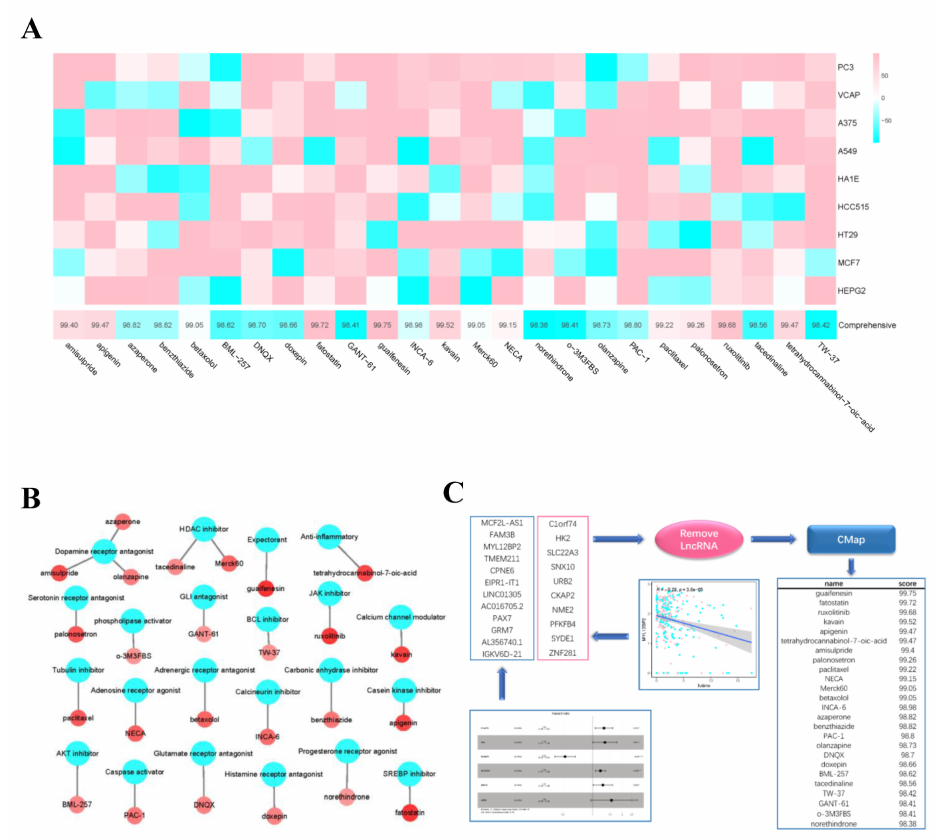
Figure 12. Drug prediction. ( A ) the abscissa of the heatmap is the compound and score, the ordinate is the cell line, red indicates sensitivity to the compound, and blue indicates insensitivity to the compound. ( B ) Network diagram shows compounds and their functional classification. ( C ) The gene set consists of two parts, one is the genes filtered by univariate Cox analysis and lasso regression analysis, and the other is the genes that are significantly different between high- and low- risk groups and negatively correlated with survival time. CMap analysis are performed after removal of non-coding RNA, then obtain the top 25 drugs (* p < 0.05; ** p < 0.01; *** p <